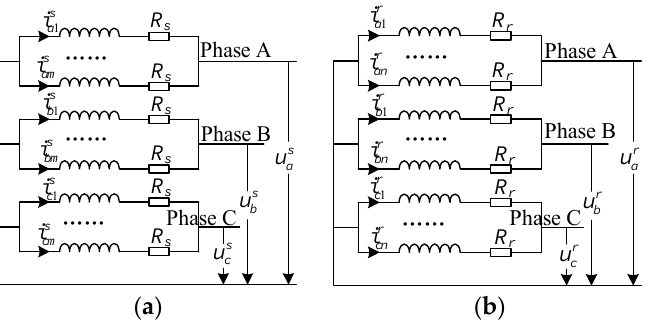
Figure 1. Equivalent circuit diagram of stator and rotor windings; ( a ) stator windings; ( b ) rotor windings.